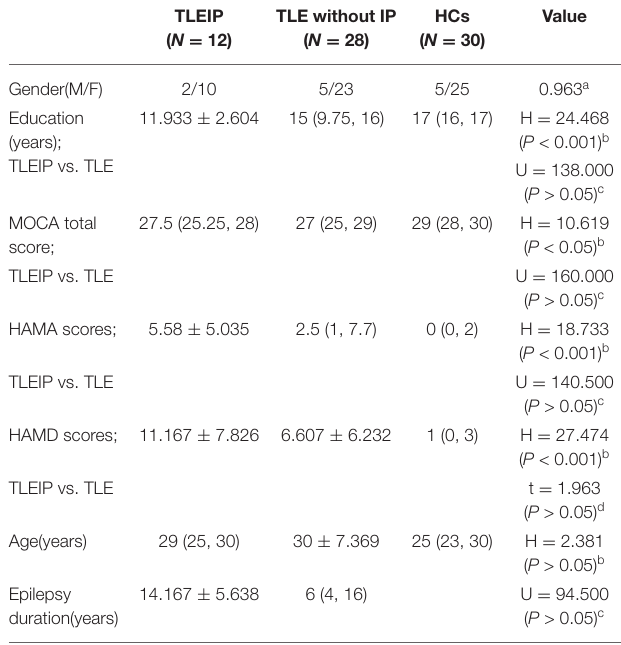
TABLE 1 | Comparison of clinical data and neuropsychological scores among the three